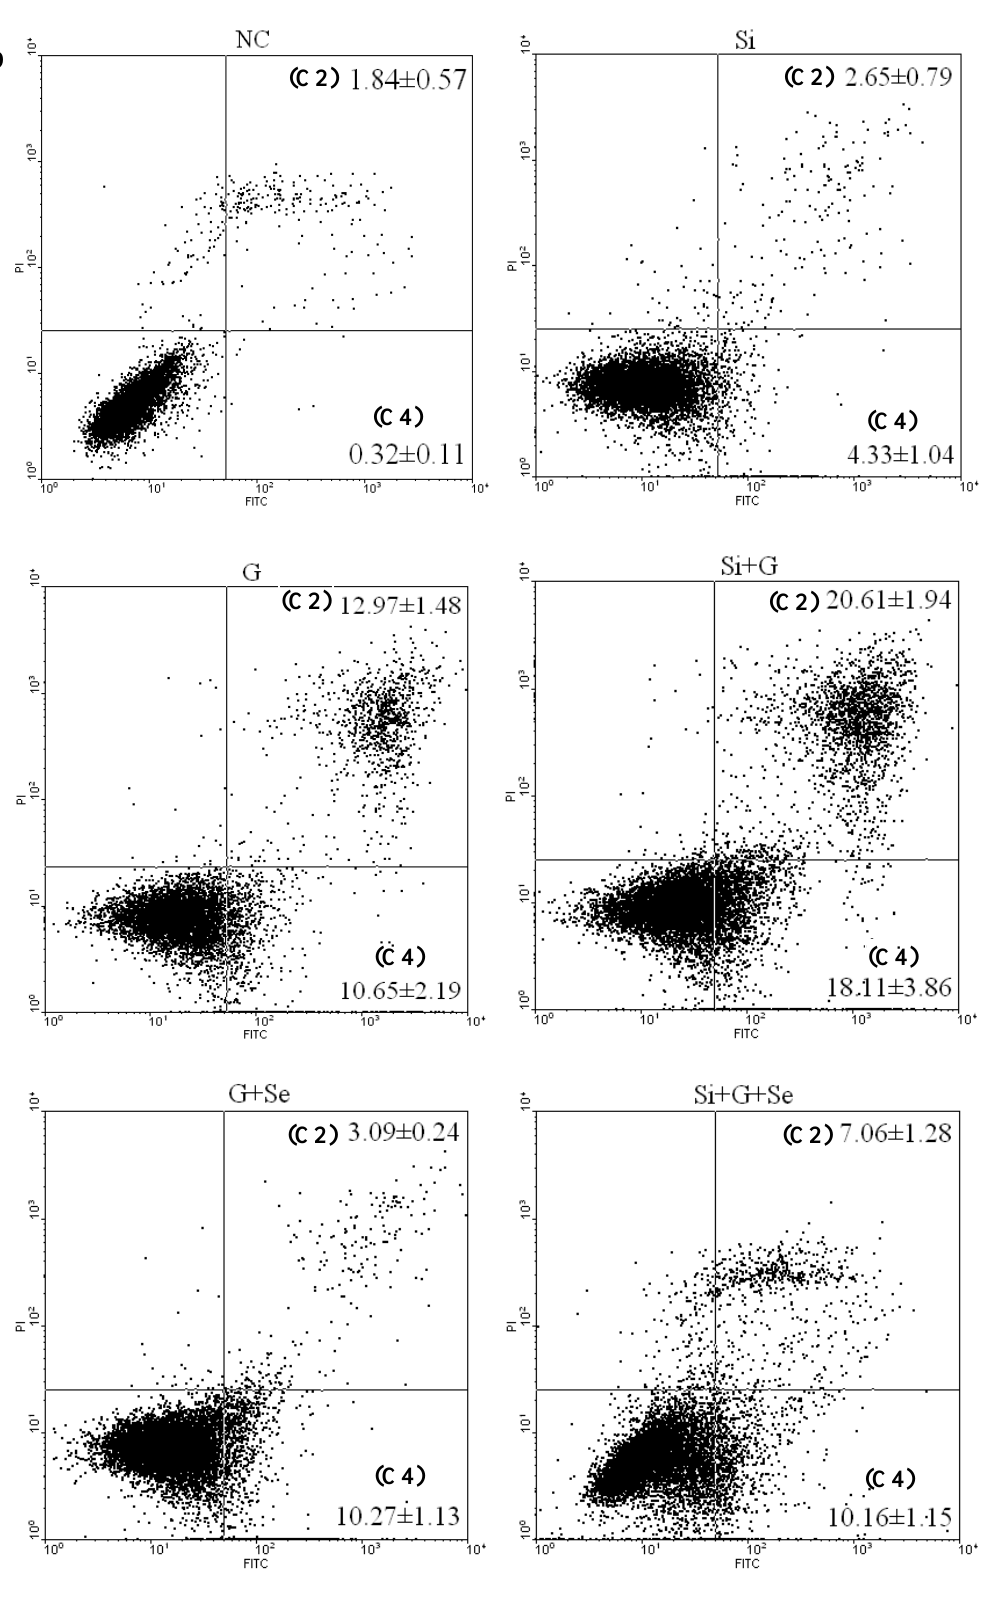
Figure 3. Cont. Figure 3.